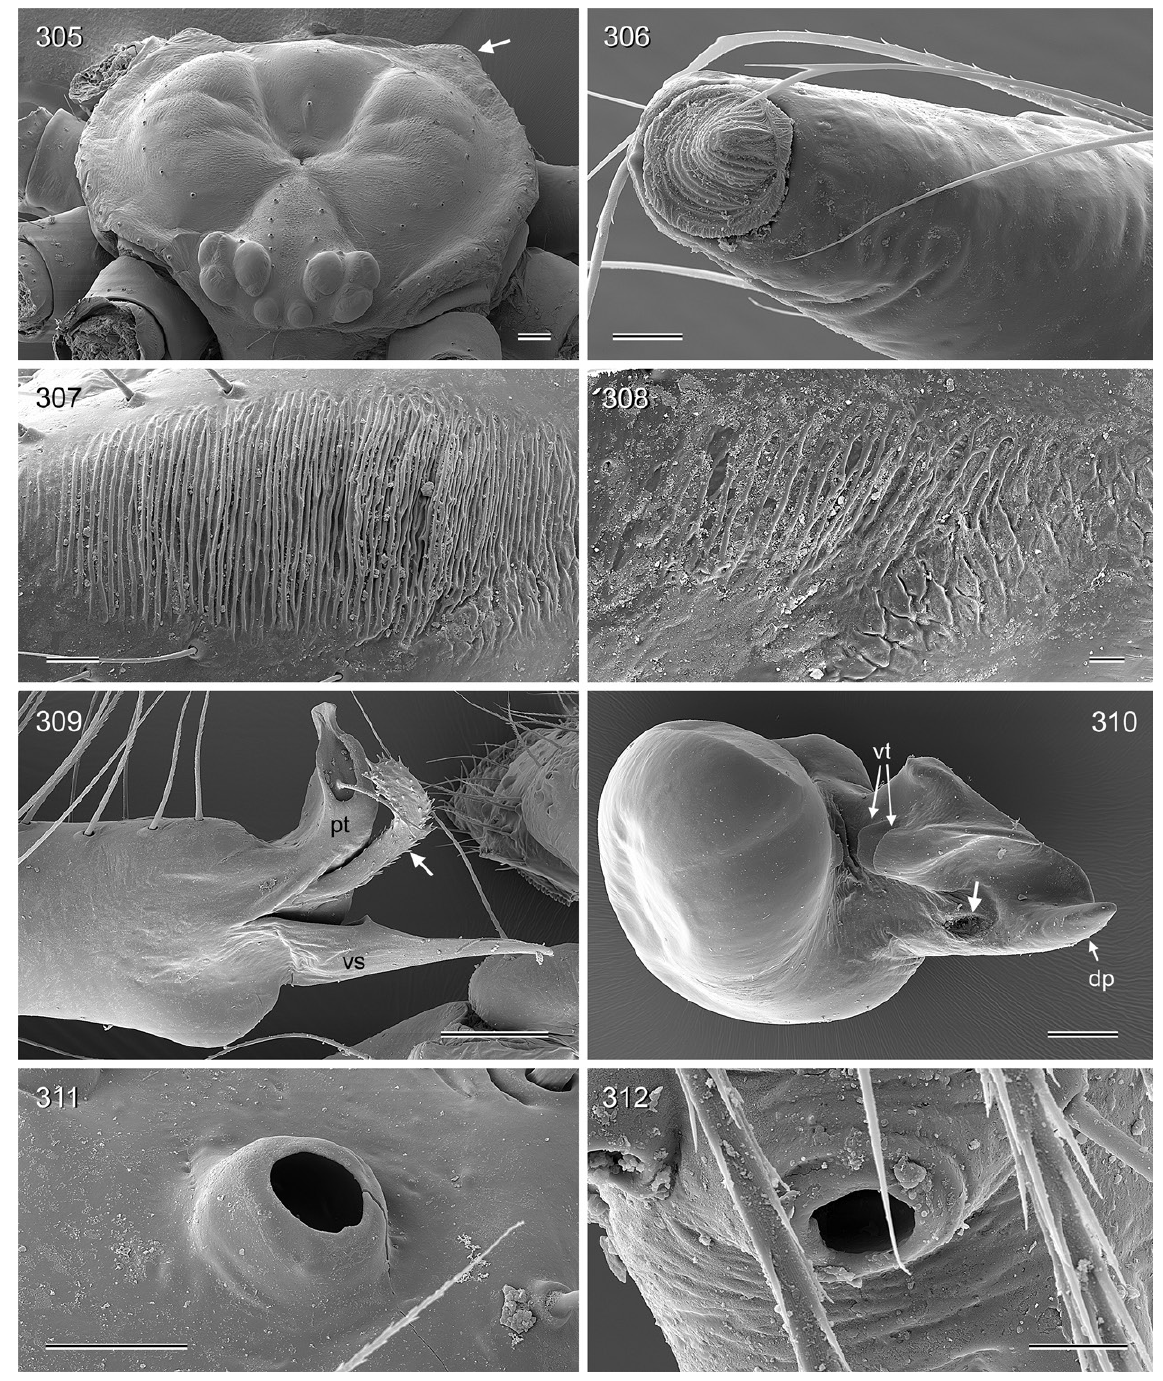
Figs 305–312. Maghreba amezyan gen. et sp. nov.; male and female from Morocco, between Lakhssas and Bouizakarne (ZFMK Ar 22353, Ar 22354). 305 . Female ocular area and carapace; arrow: posterior process. 306 . Male cheliceral apophysis. 307–308 . Male and female cheliceral stridulatory files. 309 . Right procursus, retrolateral view; arrow: transparent process. 310 . Right genital bulb, prolateral (slightly ventral) view; arrow: sperm duct opening. 311–312 . Male and female palpal tarsal organs. Abbreviations: dp = dorsal process; pt = procursus tip; vs = ventral sclerite; vt = ventral teeth. Scale bars: 305, 309–310 = 100 µm; 306, 308, 312 = 10 µm; 307, 311 = 20